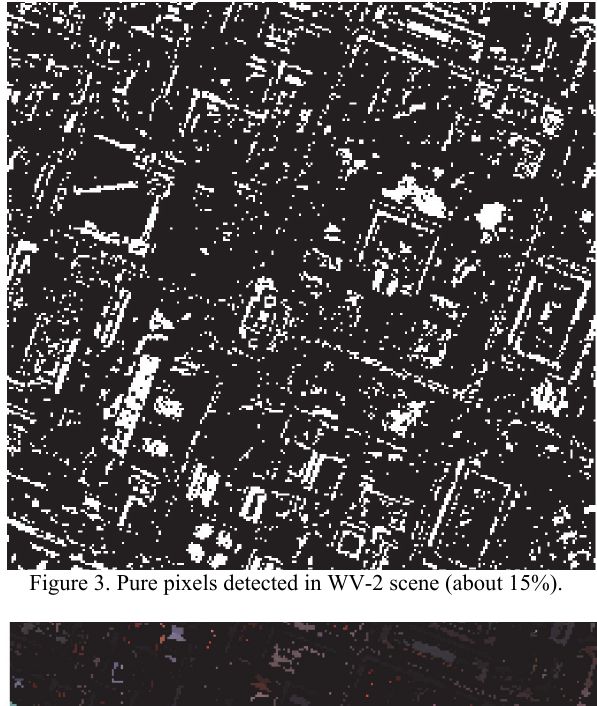
Figure 3. Pure pixels detected in WV-2 scene (about 15%).